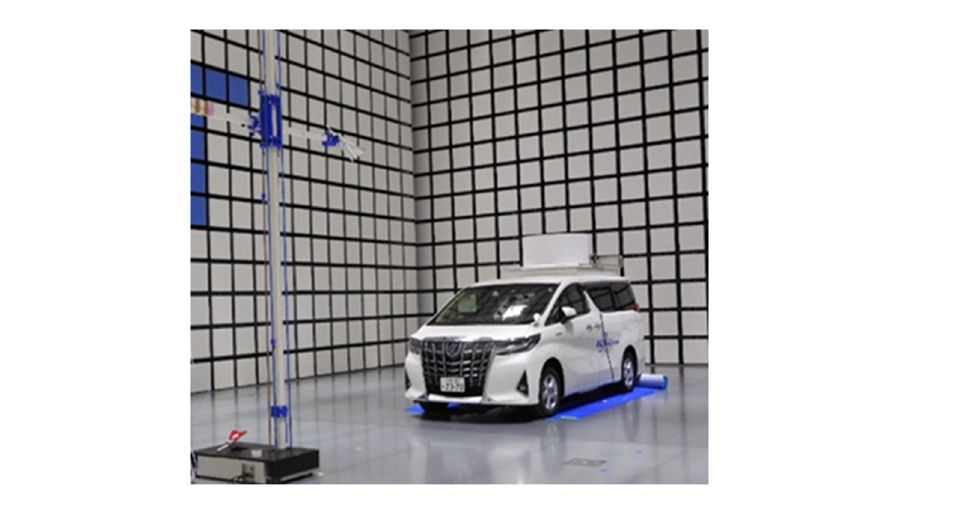
Figure 1. E-field measuring equipment in a radome mounted on a car in an anechoic chamber.